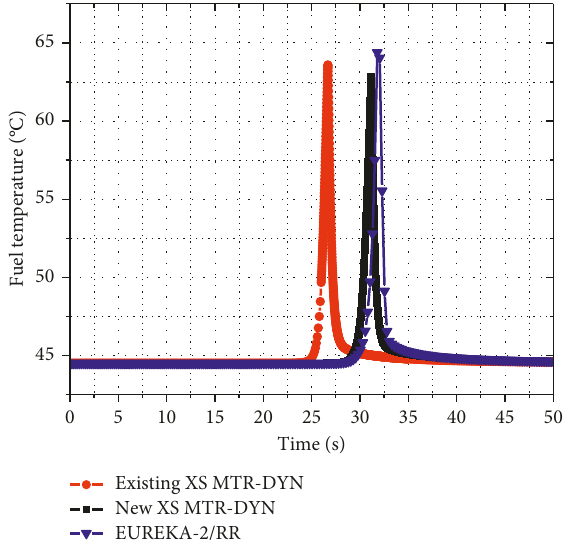
Figure 12: Fuel temperature during RIA transient at initial power 1